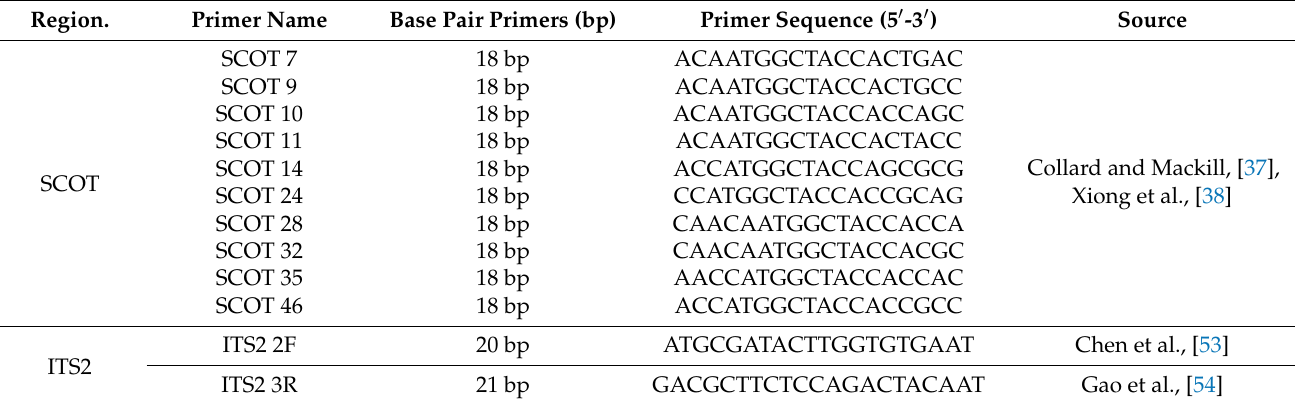
Table 3. The universal primers of SCoT, ITS2 and their sequencing region.